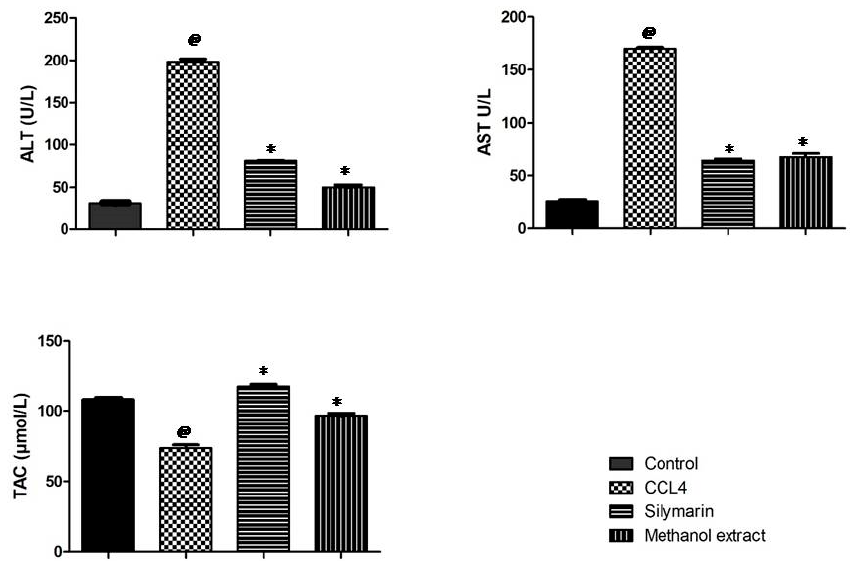
Figure 2. Hepatoprotective effect of Caesalpinia gilliesii leaves on liver biomarkers in CCl 4 -induced hepatotoxicity in rats ( n = 6). @ p < 0.01 vs control group. * p < 0.01 vs CCl 4 group. Molecules 2019 , 24 , x FOR PEER REVIEW